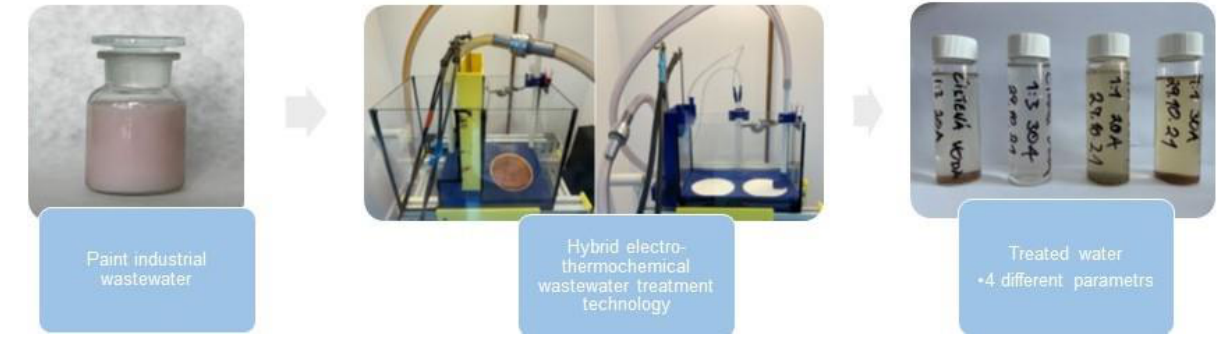
Figure 5. The hybrid electro-thermochemical wastewater treatment technology [6]. Table 5. Combination treatment methods for paint industry wastewater. Treatment Method Treatment